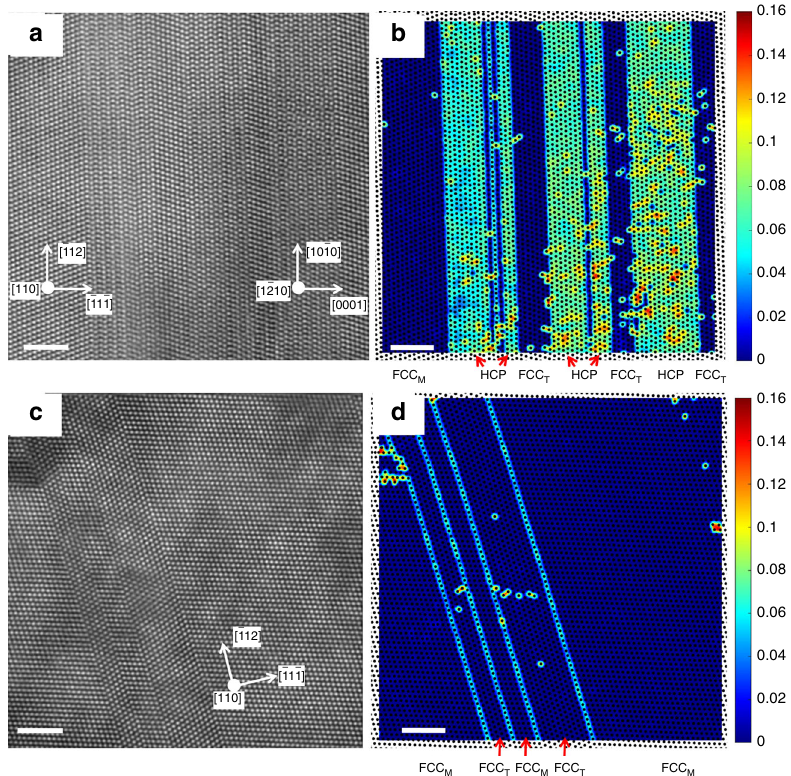
Fig. 1 Deformation substructure in CrCoNi and CrMnFeCoNi alloys tested at cryogenic temperature. HAADF-STEM images show ( a ) a well-developed nanotwin-HCP lamellar structure in CrCoNi and ( c ) a nanotwin structure in CrMnFeCoNi. The corresponding center of symmetry maps are shown in b , d , respectively. The center of symmetry maps highlight the degree to which the local environment deviates from a FCC crystal (cf. Methods section). FCC M and FCC T refer to the matrix and twin in the FCC crystal, respectively. All scale bars represent 2 nm